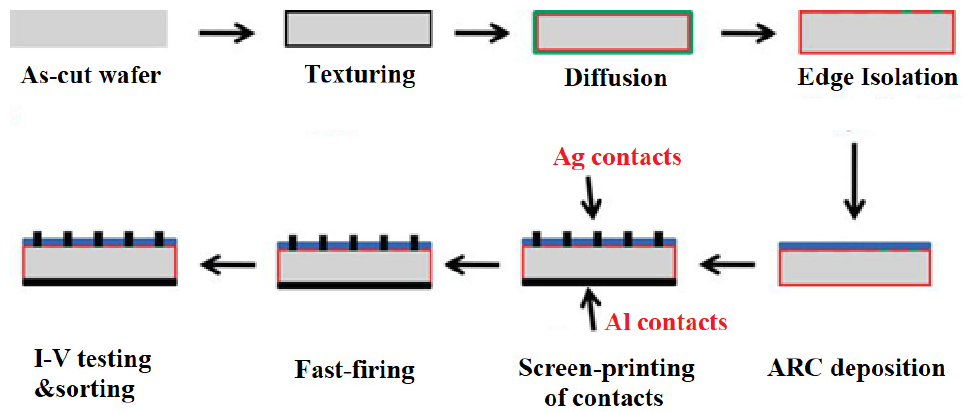
Figure 6. Al-BSF solar cell manufacturing process [21].